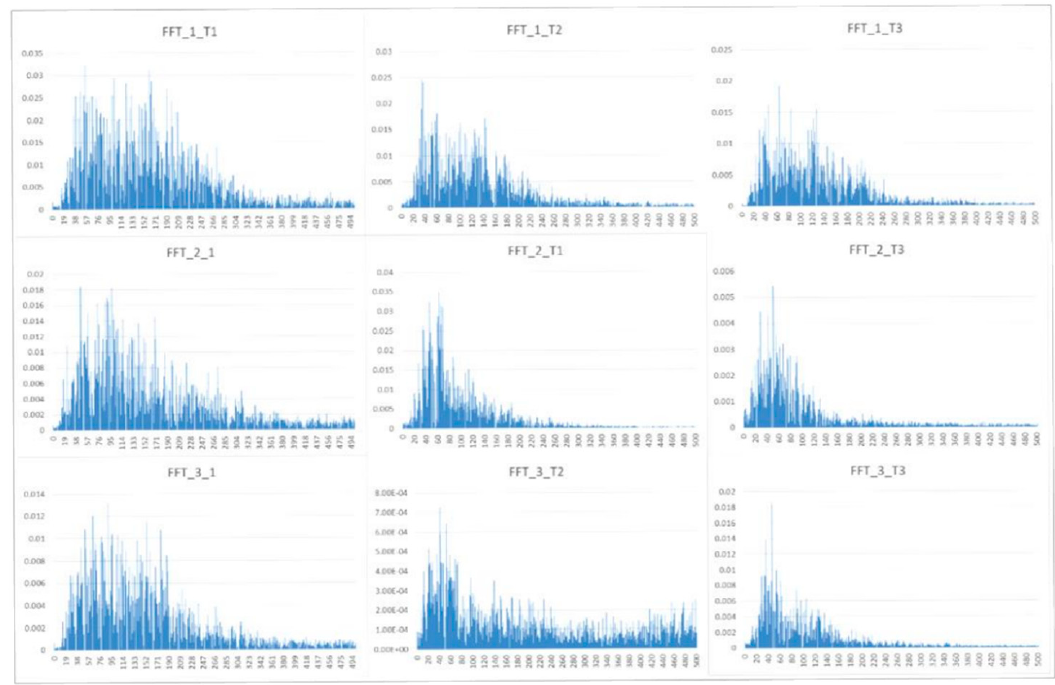
Figure 1. Examples of fast Fourier transformation (FFT) analysis of three participants in different time frames (in the beginning, T1, in the middle, T2, and in the end of the trial, T3), displayed as a plot of frequency in Hz ( x -axis) against signal energy ( y -axis).